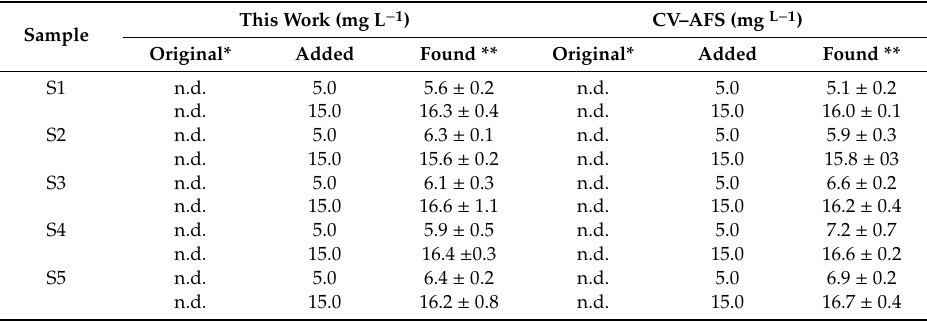
Table 2. Determination of mercury (II) in water samples using the Au-Ag BNPs colorimetric sensor and CV–AFS